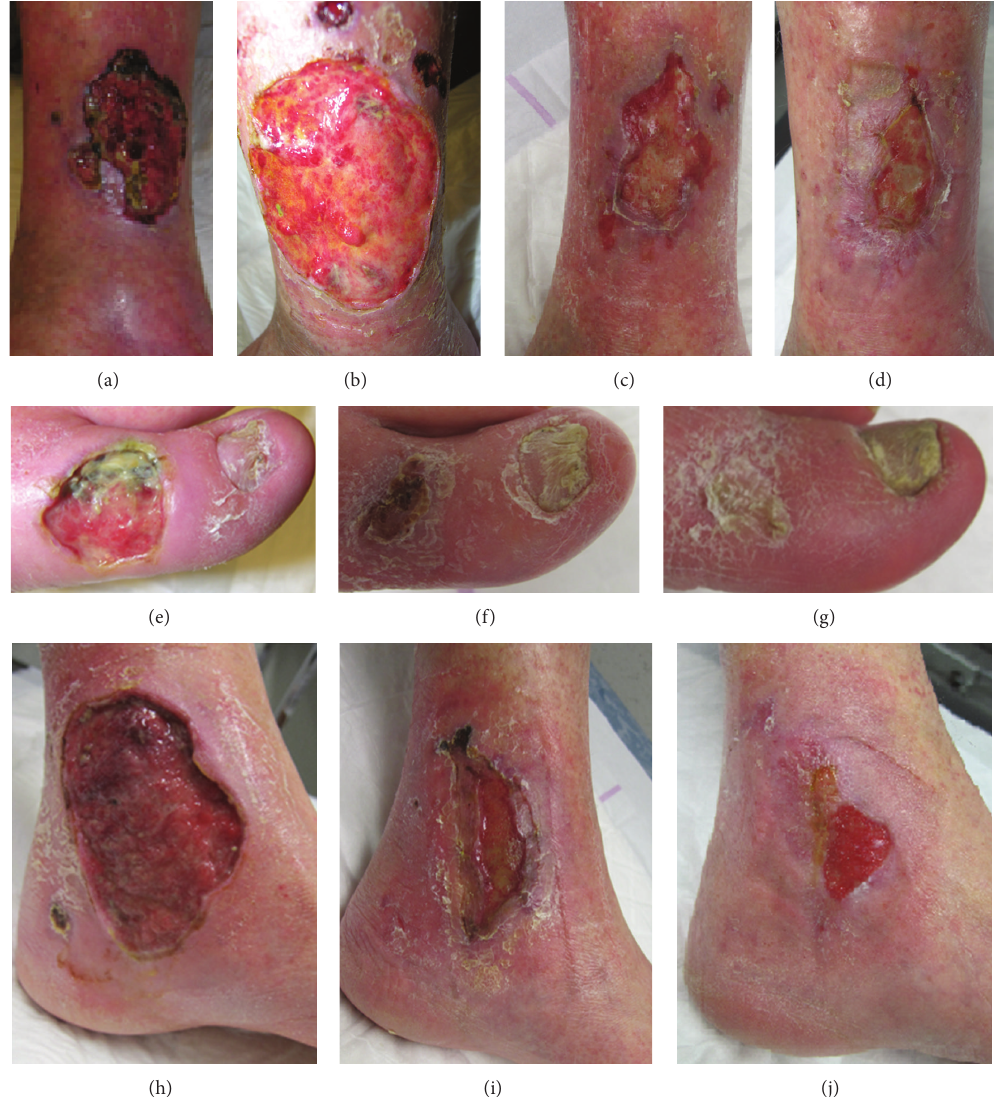
Figure 1: Clinical course of skin ulcers. (a) Skin ulcer with necrotic tissue and cyanotic skin of the left outer ankle 6 months before starting bosentan, (b) at the start of bosentan, and (c) 4 months and (d) 6 months after the administration of bosentan. (e) Skin ulcer of the left hallux 6 months before starting bosentan, (f) after intravenous administration of prostanoids, and at the start of bosentan therapy. (g) Complete healing after 6 months of bosentan therapy. (h) Skin ulcer of the left inner ankle at the start of bosentan, (i) after 4 months (j) and after 6 months of bosentan